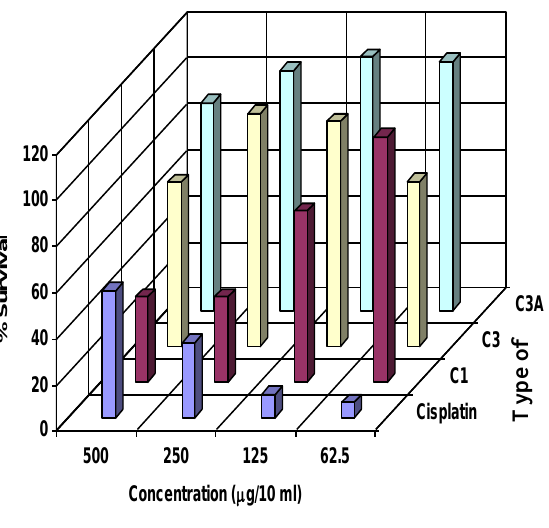
Fig 7: Three dimensional histograph of over all tested compounds (C1,C3,C3A) on HEP- 2